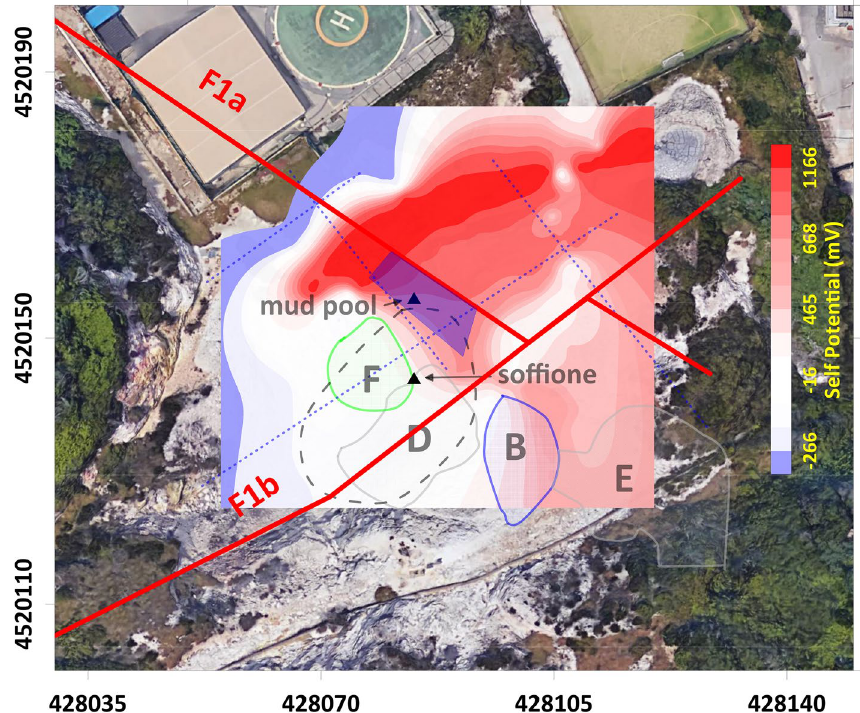
Figure 6. Traces of the main anomalies detected through the ERT and TDIP surveys (labeled with capital letters) superimposed onto the SP anomaly map shown in Fig. 5a. The color bar indicates the SP anomaly scale (in mV). The red lines indicate the two main fault systems crossing the area (redrawn from 9 ). The blue dotted lines indicate the main alignments of the elongated branches that cross part of the LRV. The figure was created using the MATLAB R2020b commercial software (https:// www. mathw orks. com/ produ cts/ MATLAB. html) and postprocessed using the Corel Draw 17 commercial software (https:// www. corel draw. com/ it/ produ ct/ corel